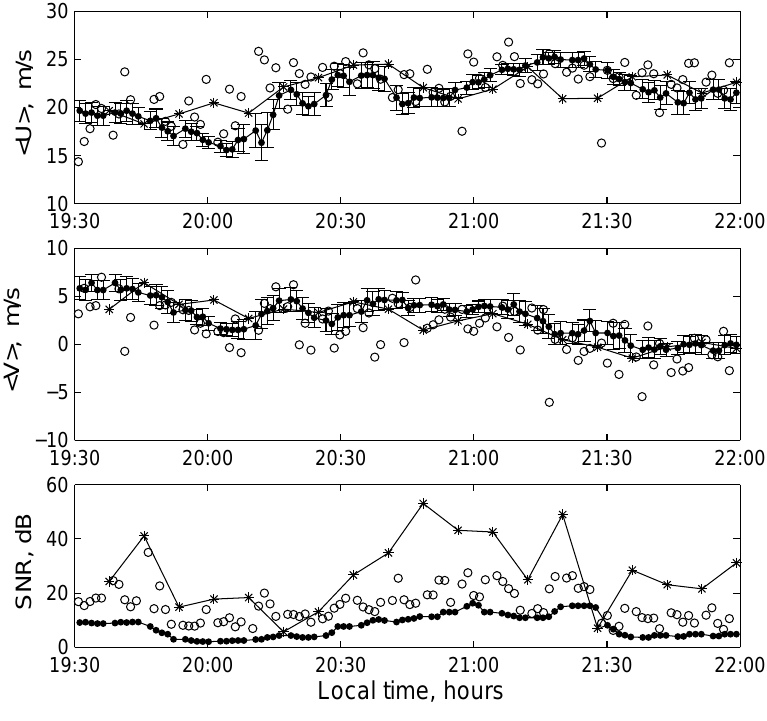
Fig. 4. The same as in Fig. 3 at z o = 7 .